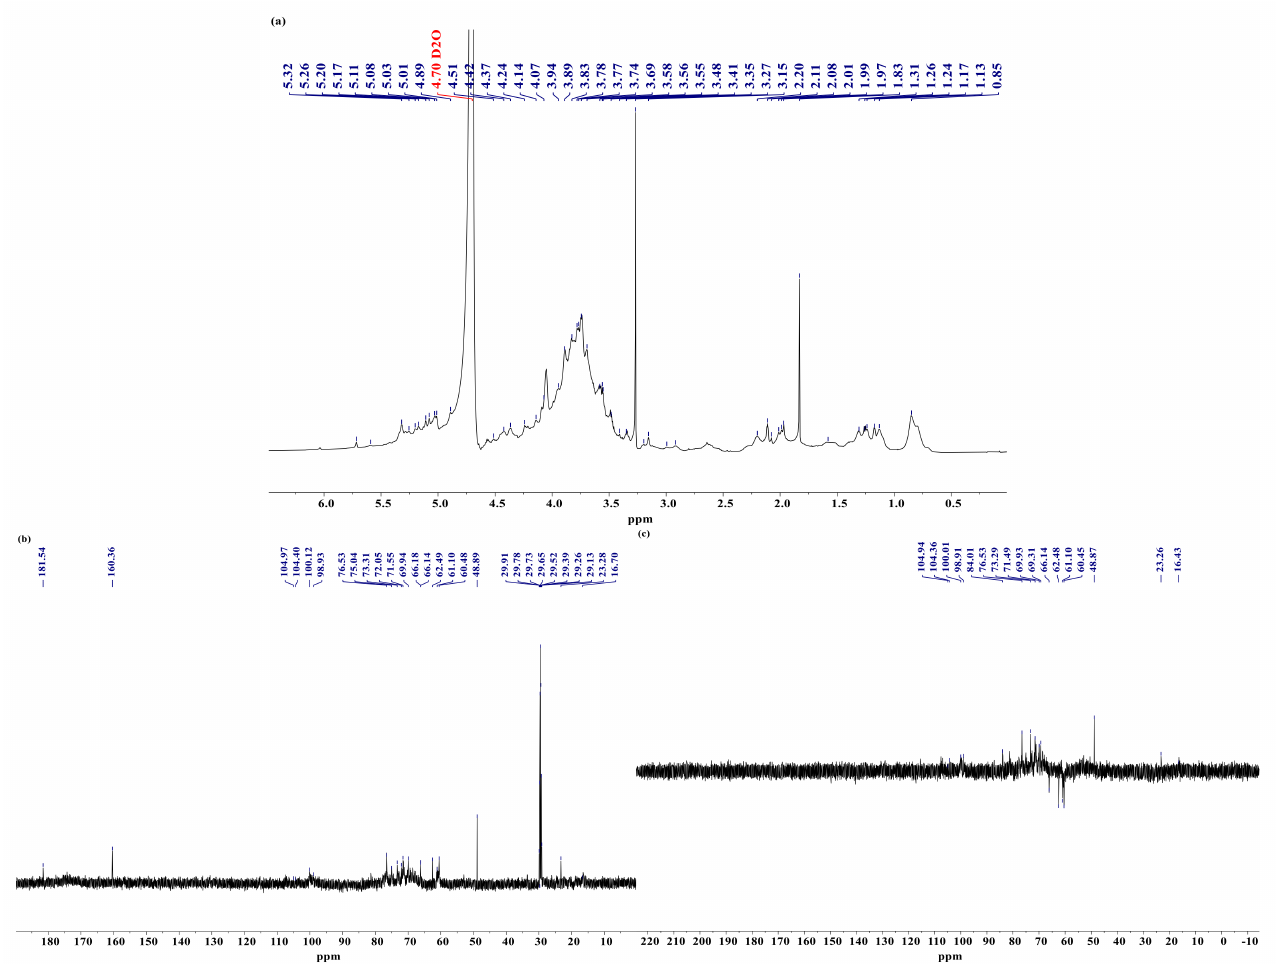
Figure 8. 1D-NMR spectrum of YPA-II. ( a ) 1 H-NMR; ( b ) 13 C-NMR; ( c ) 135